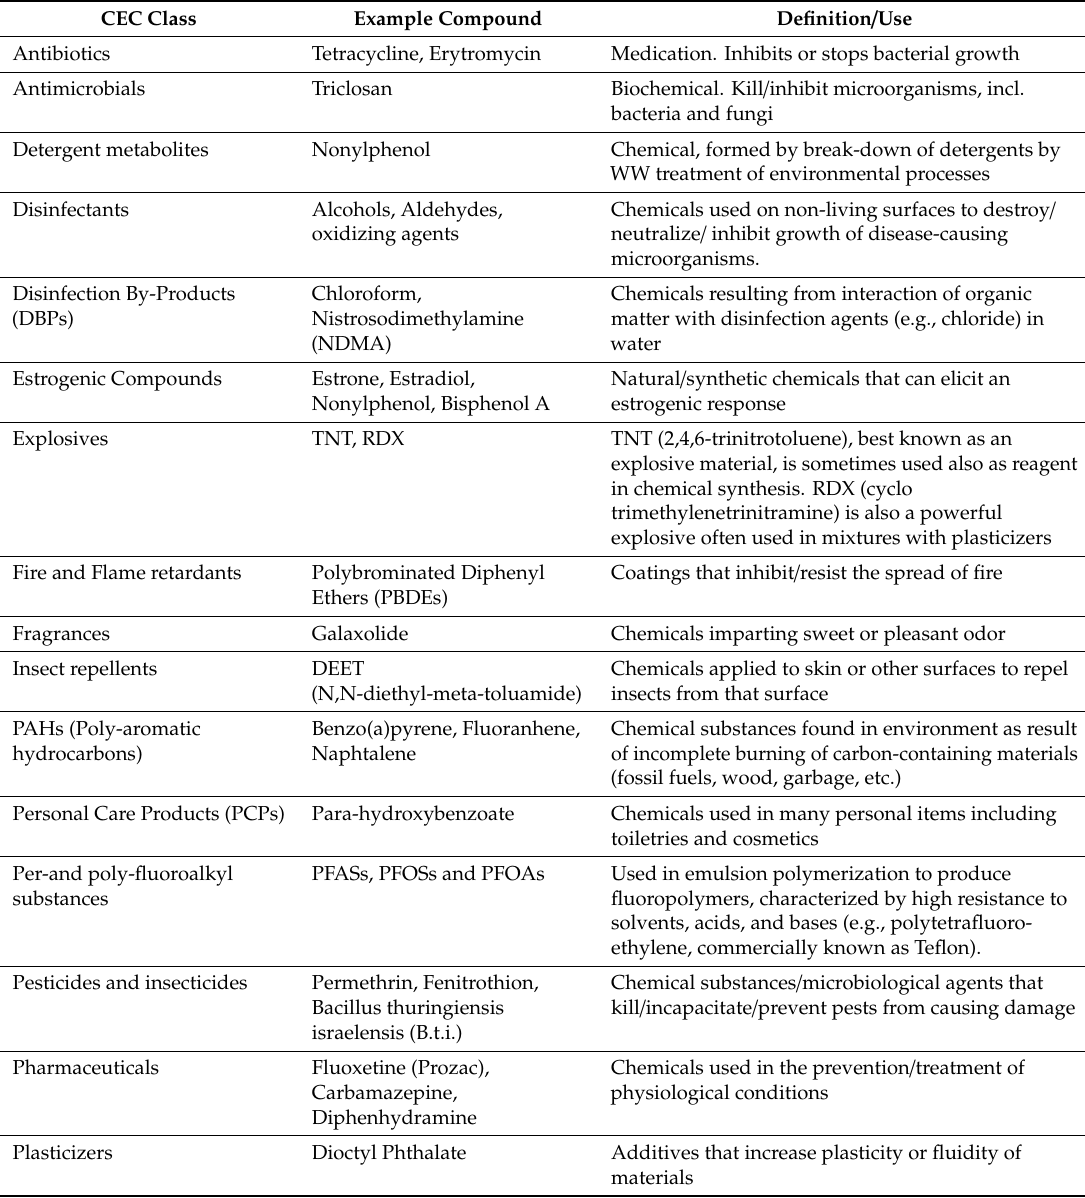
Table 1. Common CEC classes (elaborated from